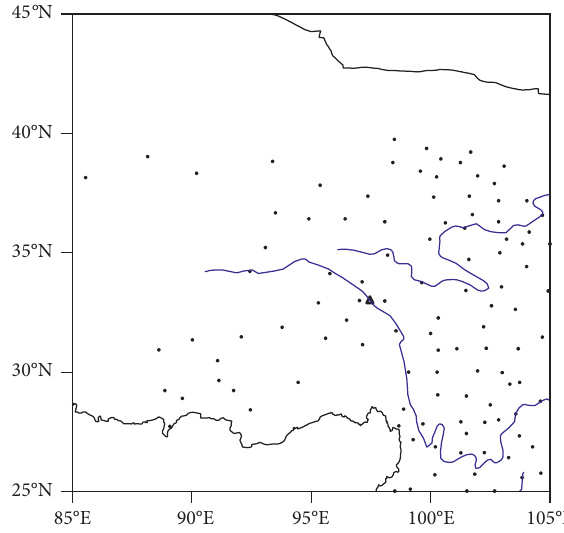
Figure 1: The location of the 109 meteorological stations (black circular points) and Zhimenda station (black